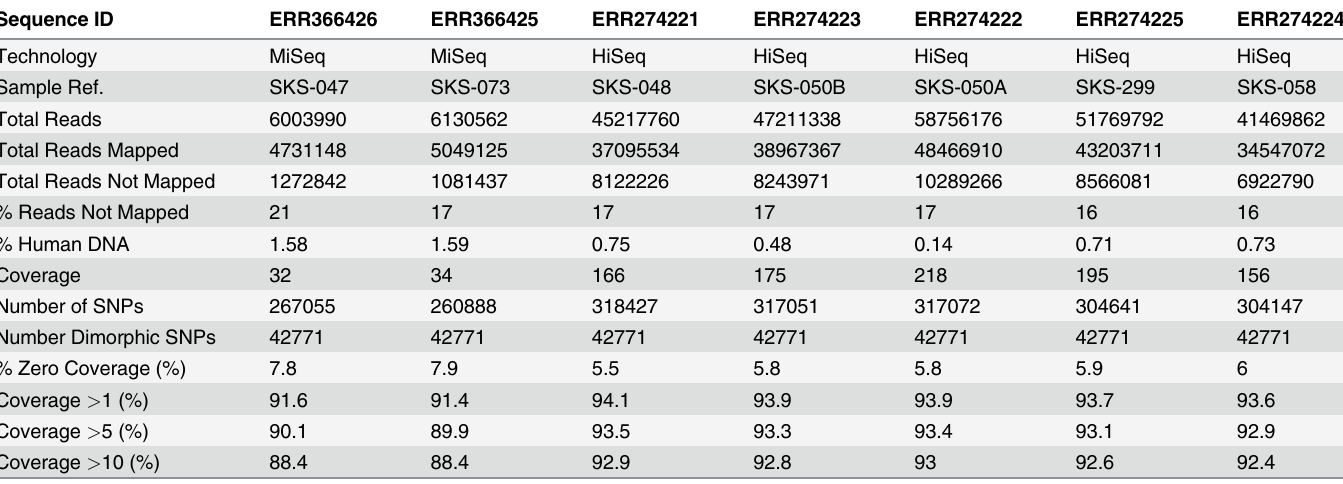
Table 2. P . knowlesi clinical isolate genome sequence summary